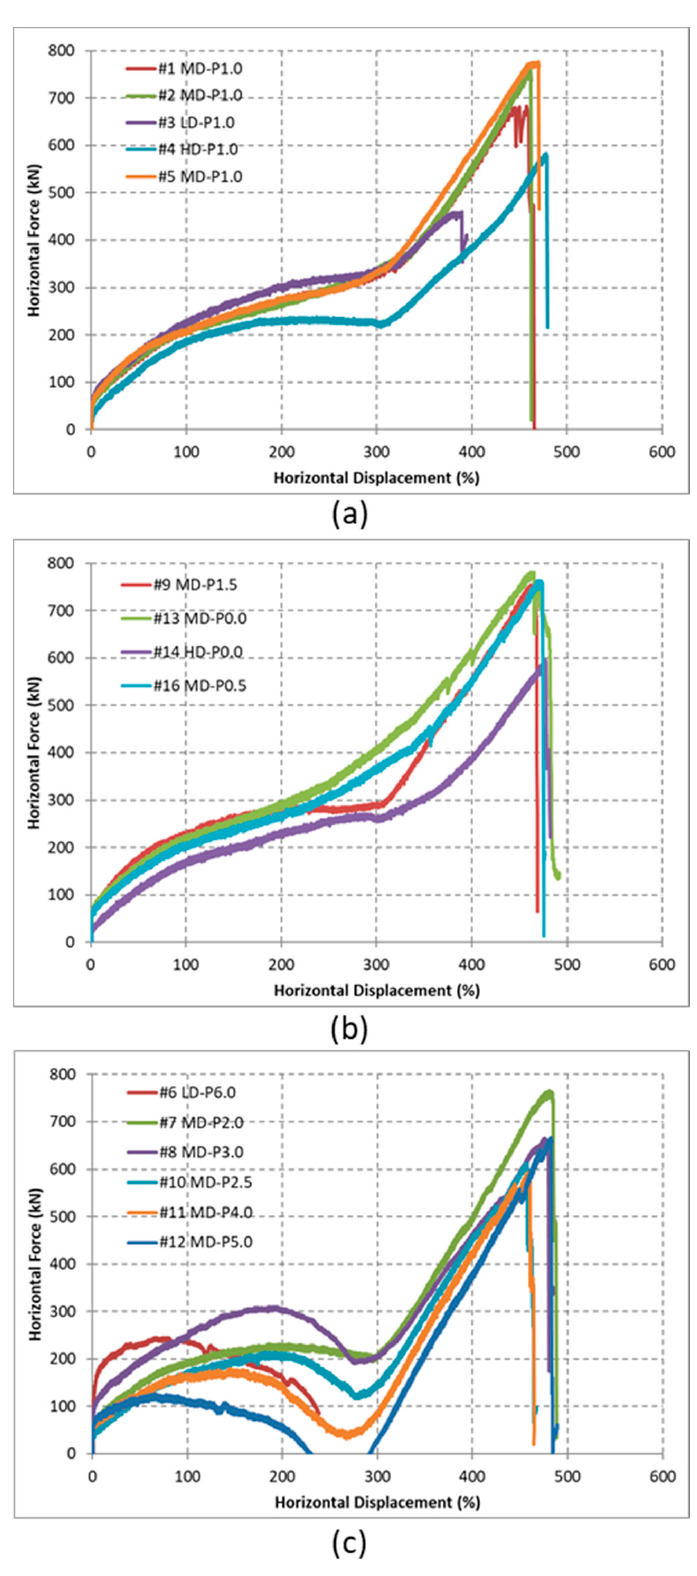
Figure 15. Force-displacement relationship of the LRBs for P/P d ratios of ( a ) P = 1.0 P d , ( b ) P = 0–1.5 P d , and ( c ) P = 2.0–6.0 P d and ( c ) P = 2.0–6.0 P d .